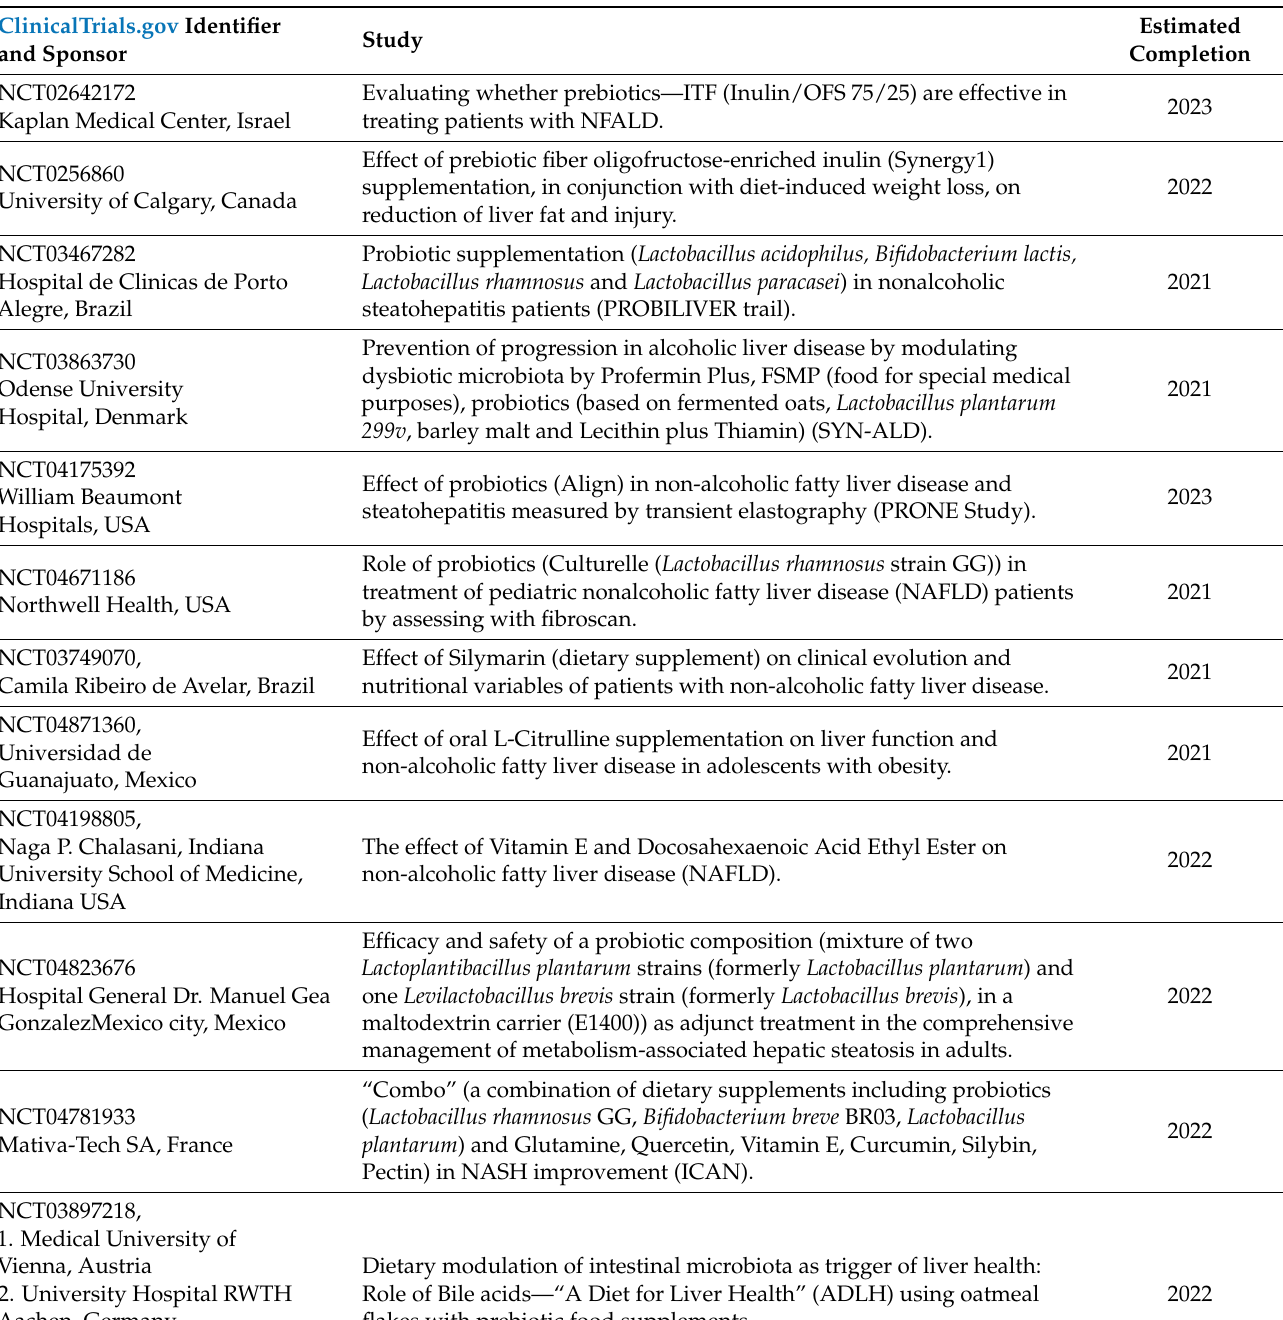
Table 1. Summary of ongoing pre-, pro, synbiotics and FMT clinical trials for treatment of liver